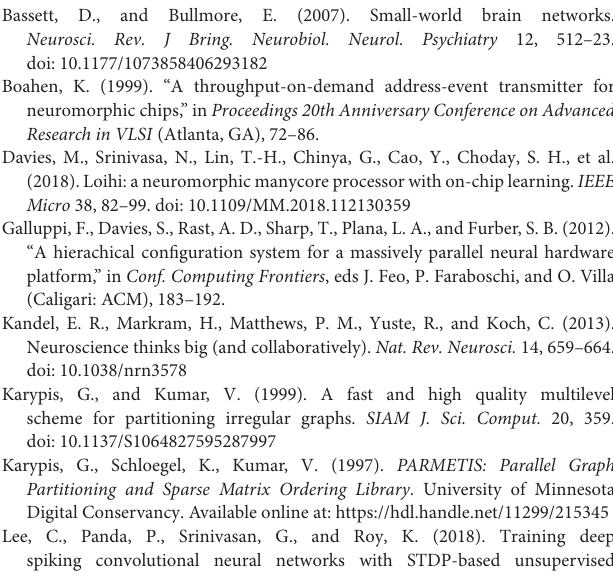
arrangement for a particular hierarchical structure of